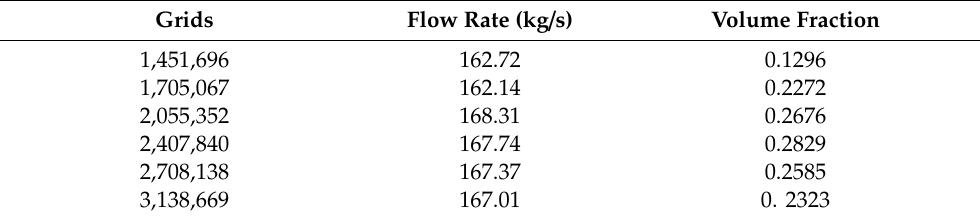
Table 1. Mesh independency check of various